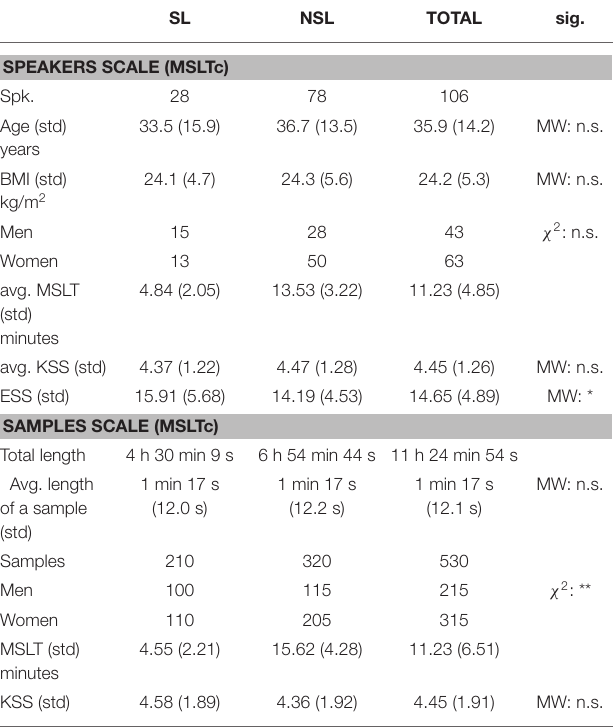
TABLE 5 | Global statistics of the MSLTc on the speaker and the sample